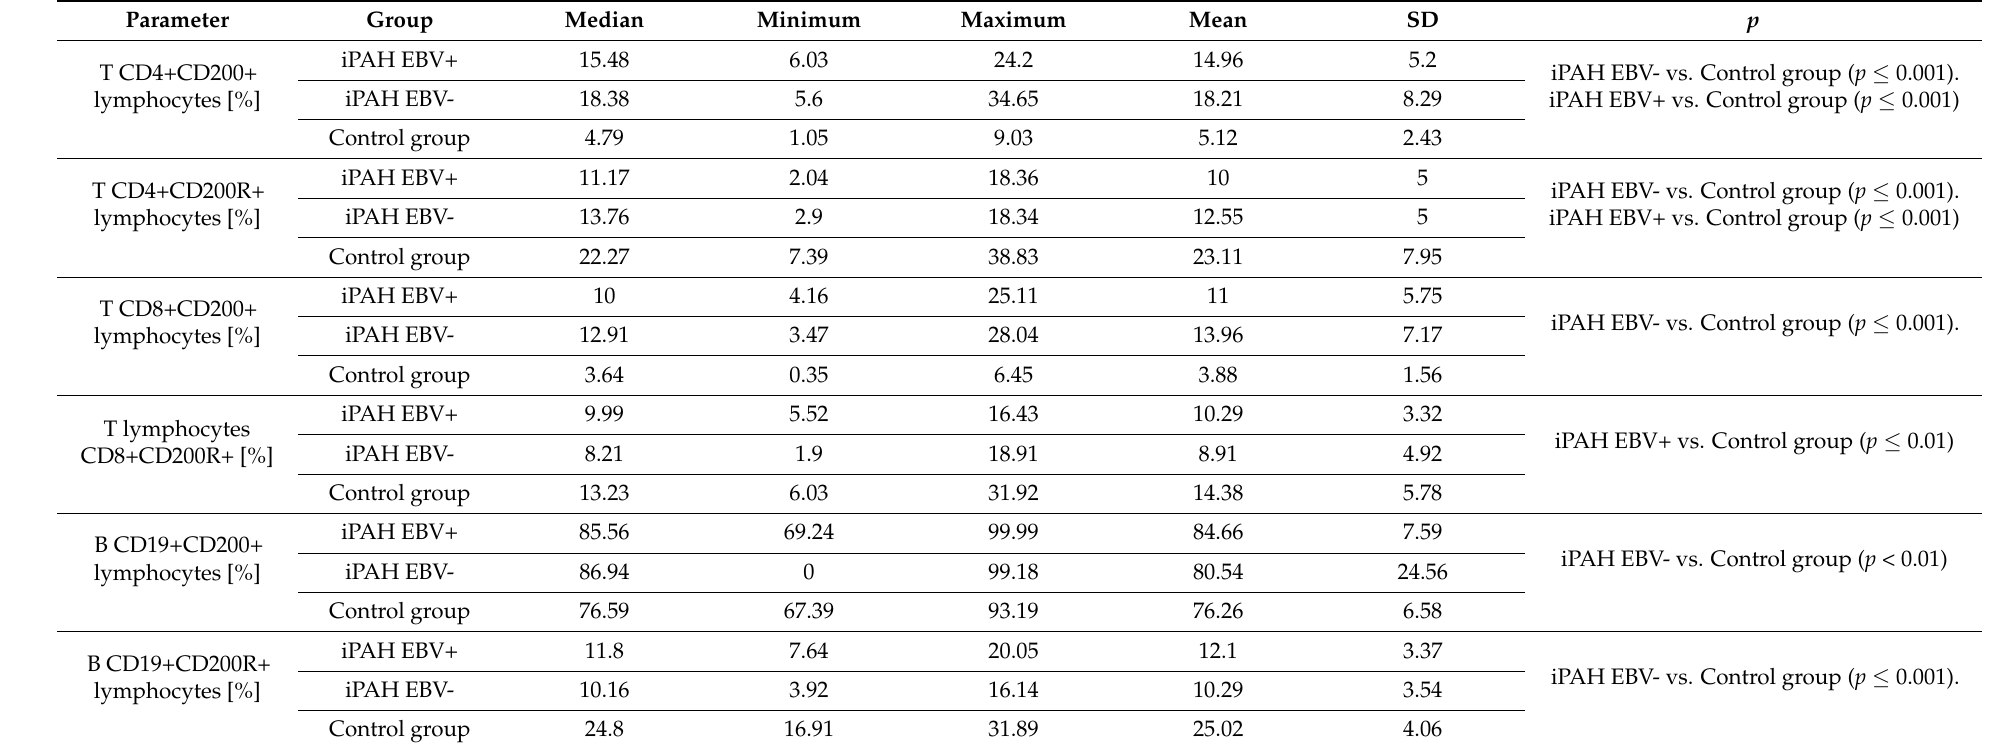
Table 6. Percentage of lymphocytes expressing CD200 and CD200R molecules in patients with iPAH, divided into EBV (+) and EBV (-) groups. Parameter